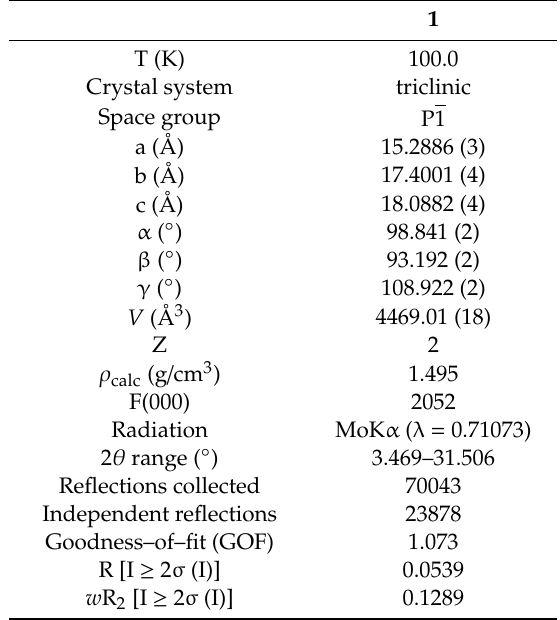
Table 2. Crystal data and structure refinement parameters for 1